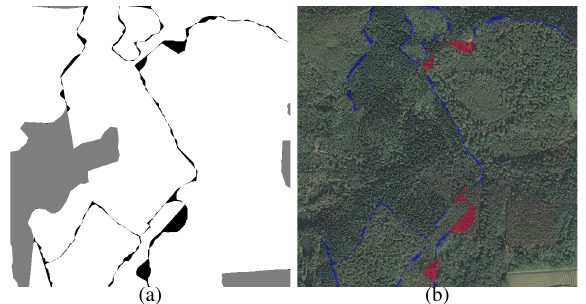
Figure 10. Differences between the human delineation and our segmentation. In (a), white is a correct classification of species, black is a wrong classification and grey is unknown (i.e., no polygon). In (b), erroneous areas are superposed on the orthoim- age, blue corresponds to errors due to the uncertainty of the bor- der, red corresponds to misclassification. Figure 11 shows how well our method fits to the forest borders. Some borders are modified and are more consistent visually.